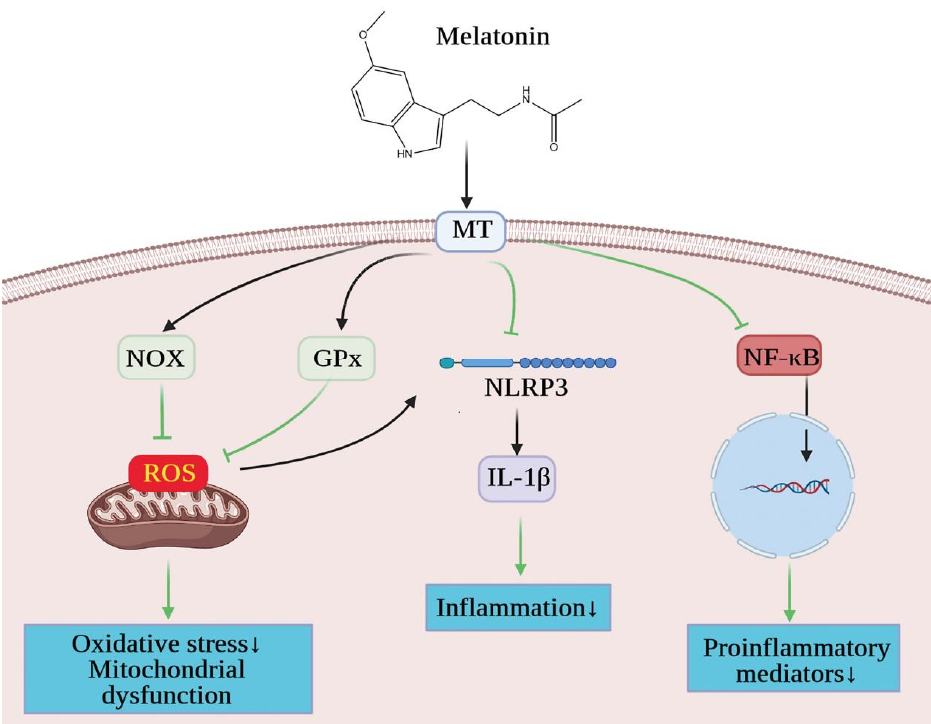
Figure 7. Therapeutic effect of melatonin on obesity-related kidney injury. Melatonin acts through melatonin receptors on the cells of the kidney. Melatonin can eliminate the excessive free radicals produced by mitochondria through antioxidant enzymes, alleviate mitochondrial dysfunction and play an antioxidant role. Melatonin can down-regulate NLRP3 inflammasome, which participates in the development of renal disease associated with obesity and may be a key regulator of obesity. Melatonin can also inhibit transcription factors including NF- κ B, reduce the transcription of pro- inflammatory mediators, thereby reducing the level of inflammation, and fundamentally treat the kidney damage caused by obesity. GPx, Glutathione peroxidase; IL-1 β , interleukin-1 β ; MR, melatonin receptor; NF- κ B, nuclear factor kappa-B; NLRP3, NLR Family Pyrin Domain Containing 3; NOX, NADPH oxidase; ROS, reactive oxygen species. “ ↓ ” represents a